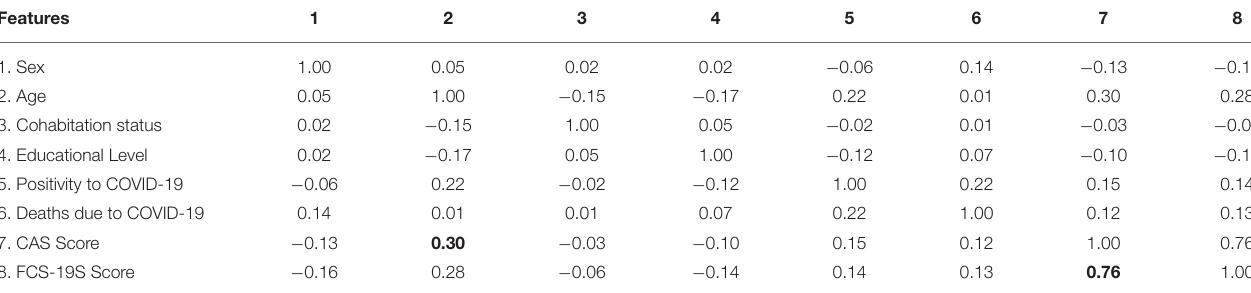
TABLE 2 | Spearman’s correlation coefficient ( r ) among CAS, FCS-19S, demographics, and COVID-19 situational experiences. Features